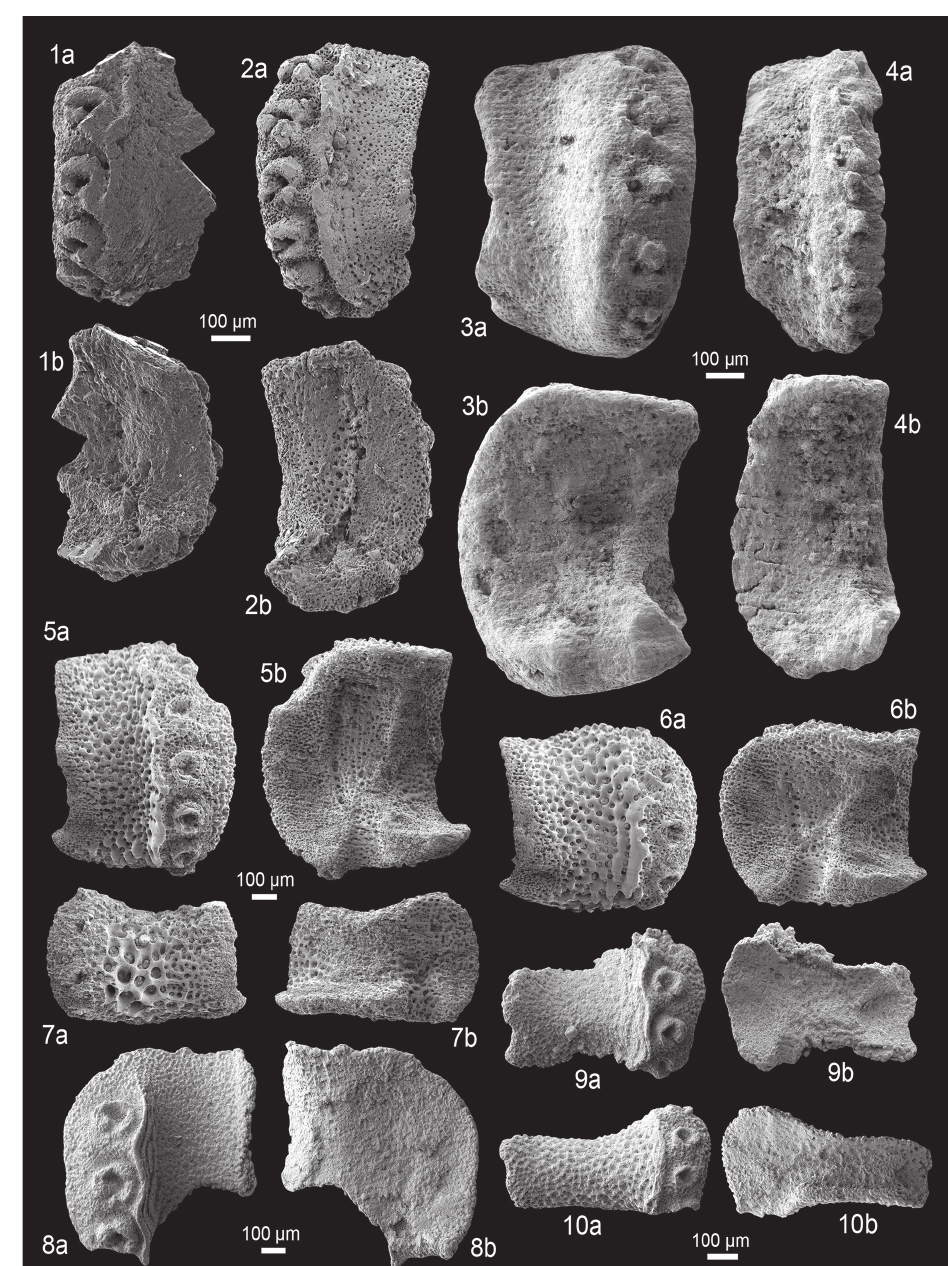
Fig. 18. Fossil lateral arm plates (LAPs) of ophiacanthid brittle stars in external (a) and internal (b) views. 1-2. Ophiotreta sp. nov. innom 2 from the Langhian (middle Miocene) of Stotzing (1) and Mannersdorf (2), Austria. 1. NHMW 2012/0139/0003, proximal LAP. 2. NHMW 2012/0139/0001, proximal LAP. 3-4. Europacantha paciphila gen. et sp. nov. from the late Anisian (Middle Triassic) of Felsöörs, Hungary. 3. MHI 2090/1 (holotype), proximal to median LAP. 4. MHI 2091/1 (paratype), proximal LAP. 5-7. Ophiacantha jaegeri sp. nov. from the latest Hauterivian (Early Cretaceous) of Sarstedt, Germany. 5. GZG.INV.78595 (holotype), proximal LAP. 6. GZG.INV.78596 (paratype), median LAP. 7. GZG. INV.78597 (paratype), distal LAP. 8-9. Ophiacantha sp. nov. innom 1 from the latest Aptian to earliest Albian (Early Cretaceous) of Blake Nose, NE Atlantic. 8. GZG.INV.78599, proximal LAP. 9. GZG. INV.78600, distal LAP. 10. Ophiacantha sp. nov. innom 2 from the latest Aptian to earliest Albian (Early Cretaceous) of Blake Nose, NE Atlantic; GZG.INV.78601, distal LAP. One common scale bar per